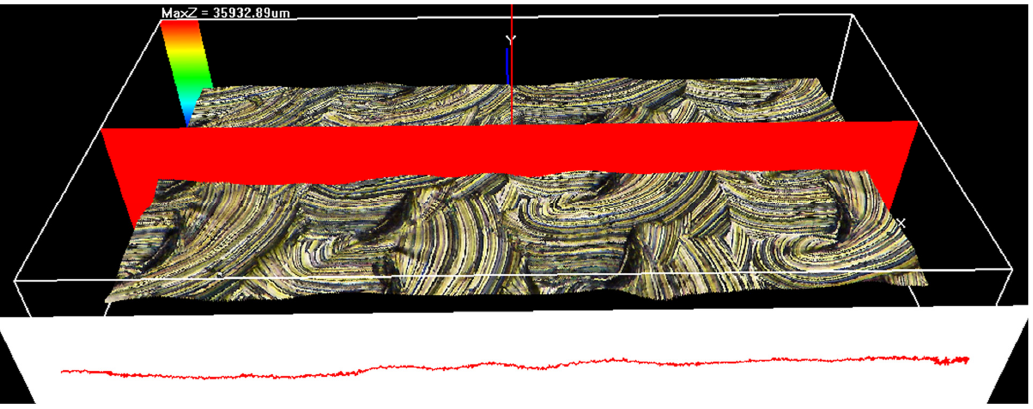
Figure 26. Workpiece surface topography machined by BEM with inclination angle of 0°.